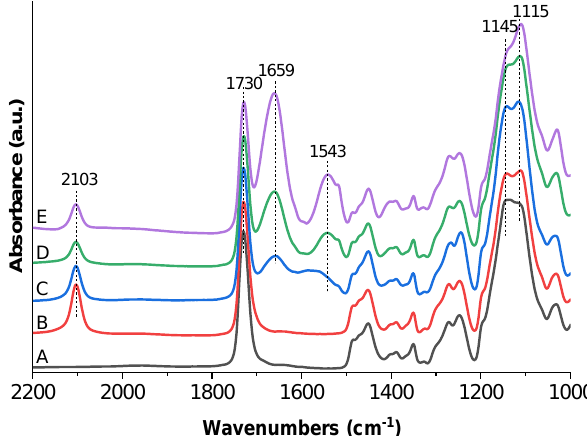
Figure 2. GAATR-FTIR spectra of polymer brush poly(MeOEGMA- block -GMA) brush grown over Si substrates before ( A ) and after reaction with azide ( B ) and after immobilization of RGD peptide to surface concentration 3.2 × 10 2 nmol/cm 2 ( C ), 1.2 × 10 3 nmol/cm 2 ( D ) and 4.6 × 10 3 nmol/cm 2 ( E ).